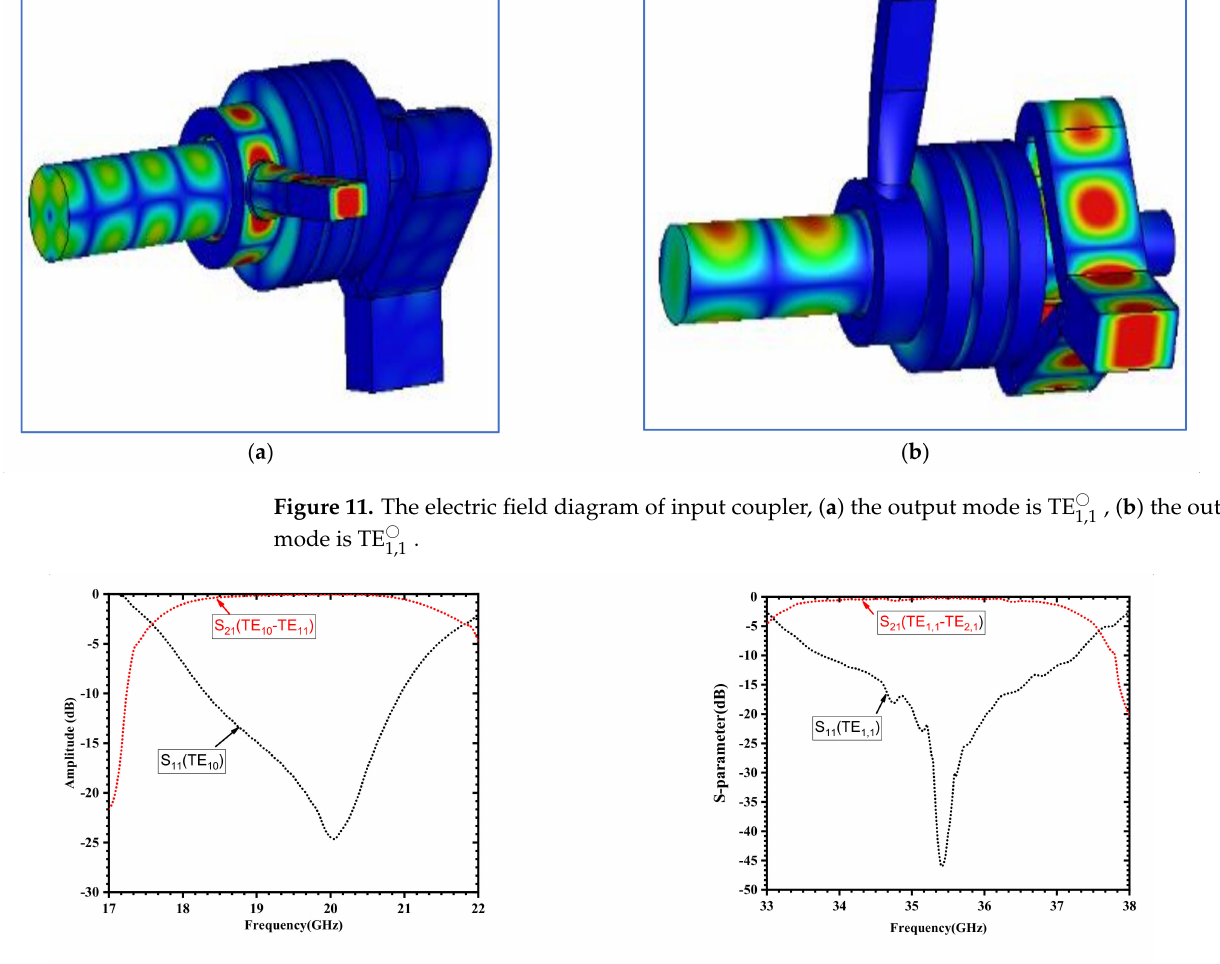
Figure 12. The S-parameter for the designed dual-mode input coupler, ( a ) the S-parameter when the output mode is TE , ( b ) the S-parameter when the output mode is TE (cid:35) 1,1